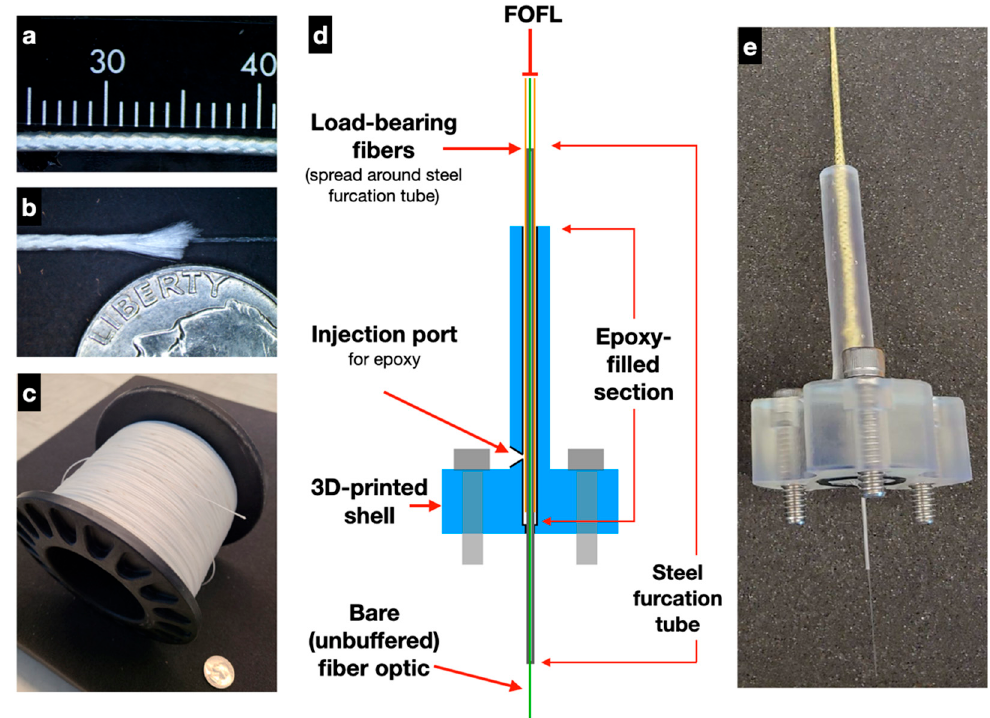
Figure 1. ( a ) Fiber optic fishing line (FOFL) comprised of UHMWPE load-bearing fibers braided around singlemode fiber optic. ( b ) View of FOFL with braided fibers cut at an end, exposing the fiber optic core, with a quarter shown for scale. ( c ) A spool of approximately 1100 m of FOFL wound on a electric fishing reel drum, with a 100 mm core diameter and 100 mm flange width. ( d ) Cross-sectional diagram of FOFL mechanical termination showing major components and epoxy-filled section inside 3D-printed housing. ( e ) FOFL mechanical termination, shown with an early prototype FOFL using Kevlar load-bearing fibers for the outer braid.